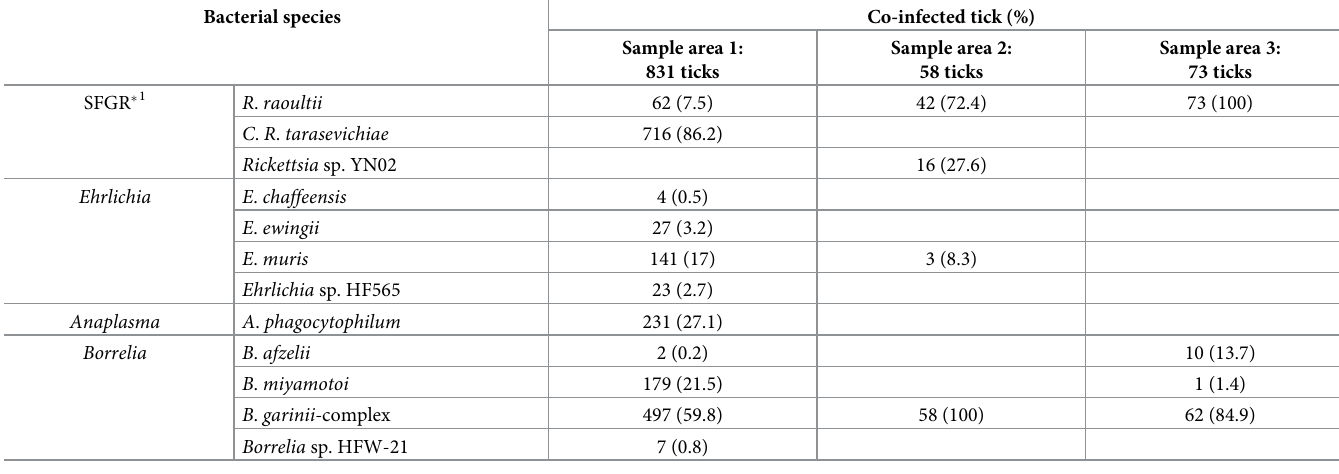
Table 3. Pathogen identified in co-infected Tick samples. Bacterial